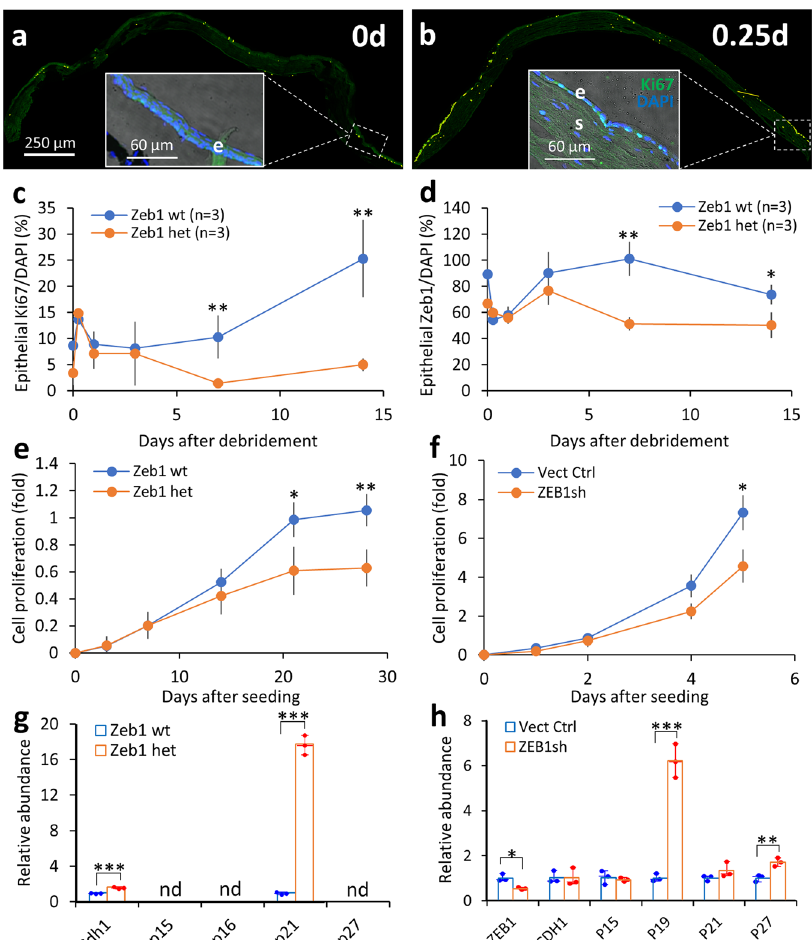
Fig. 4 KO or knockdown (KD) of ZEB1 reduces corneal epithelial cell proliferation. A representative image of the Zeb1 + / + corneal tissue sections stained with the cell proliferative marker Ki67 a before (0 day) and b on day 1 after the epithelial debridement. Inserts, the epithelium close to the limbus. For the period of 14 days after the debridement, the ratios of c the Ki67 + or d the Zeb1 + area to the DAPI + area in the epithelium of the Zeb1 wt corneas were compared with that of the Zeb1 het corneas. The comparisons of proliferation rates e between Zeb1 wt and Zeb1 het mouse primary corneal epithelial cells and f between vector control (Vect Ctrl) and ZEB1-KD (ZEB1sh) human hTCEpi cells. Relative expression levels of genes involved in cell proliferation were compared g between Zeb1 wt and Zeb1 het mouse corneal epithelial cells and h between Vect Ctrl and ZEB1sh hTCEpi cells. wt, Zeb1 + / + ; het, Zeb1 + / − ; nd, not detected; e, the epithelium; s, the stroma; * p ≤ 0.05; ** p ≤ 0.01; *** p ≤ 0.001; n , the number of corneas used. The error bars in c – f are the standard deviation (SD) bars whereas the box height in g and h is the mean with individual measurement